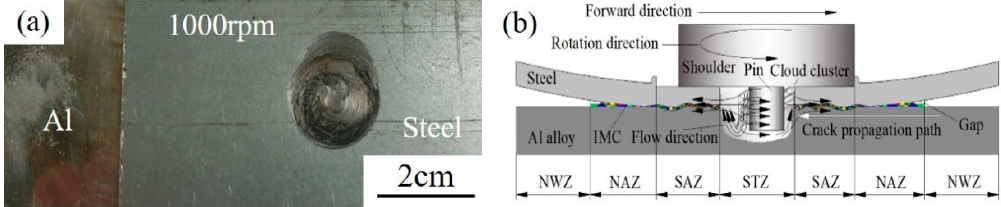
Figure 3. Macroscopic morphology ( a ) and diagram of formation ( b ) of Al/steel keyhole-free FSSW Figure3. Macroscopicmorphology( a )anddiagramofformation( b )ofAl / steelkeyhole-freeFSSWjoints. joints.